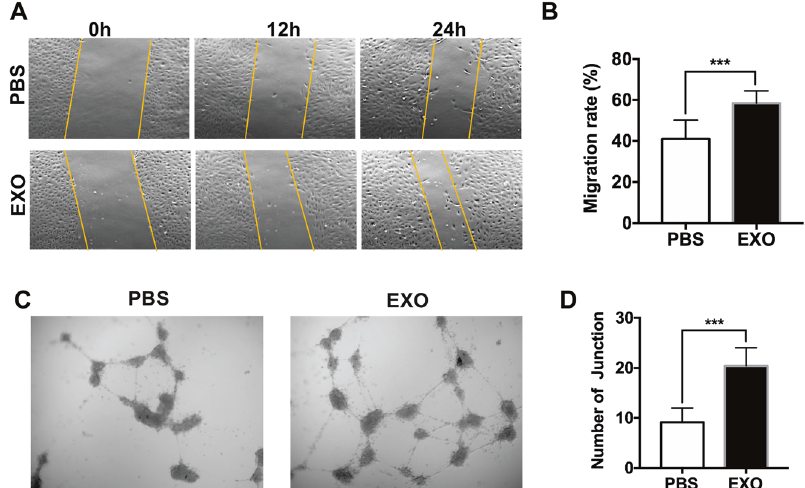
Fig. 2 Exosomes derived from WERI-Rb1 cells induce HUVEC angiogenesis and migration in vitro. A Wound-healing assay. HUVECs were treated with exosomes, and cell monolayers were scratched with 1 – 200- μ l yellow tips. Images were captured at 0, 12, and 24 h after the wound scratch. B The rate of migration was measured by quantifying the total distance that the HUVECs moved from the edge of the scratch toward the center of the scratch. Relative quanti fi cation of HUVEC migration 24 h after the wound scratch ( n = 7, *** P < 0.001). C Microscopic photographs of tubule formation on Matrigel are shown. There was a signi fi cant increase in HUVEC tubule connections in the presence of the exosomes compared with that in the presence of PBS. D The number of tubule junctions is presented in the histograms ( n = 6, *** P <